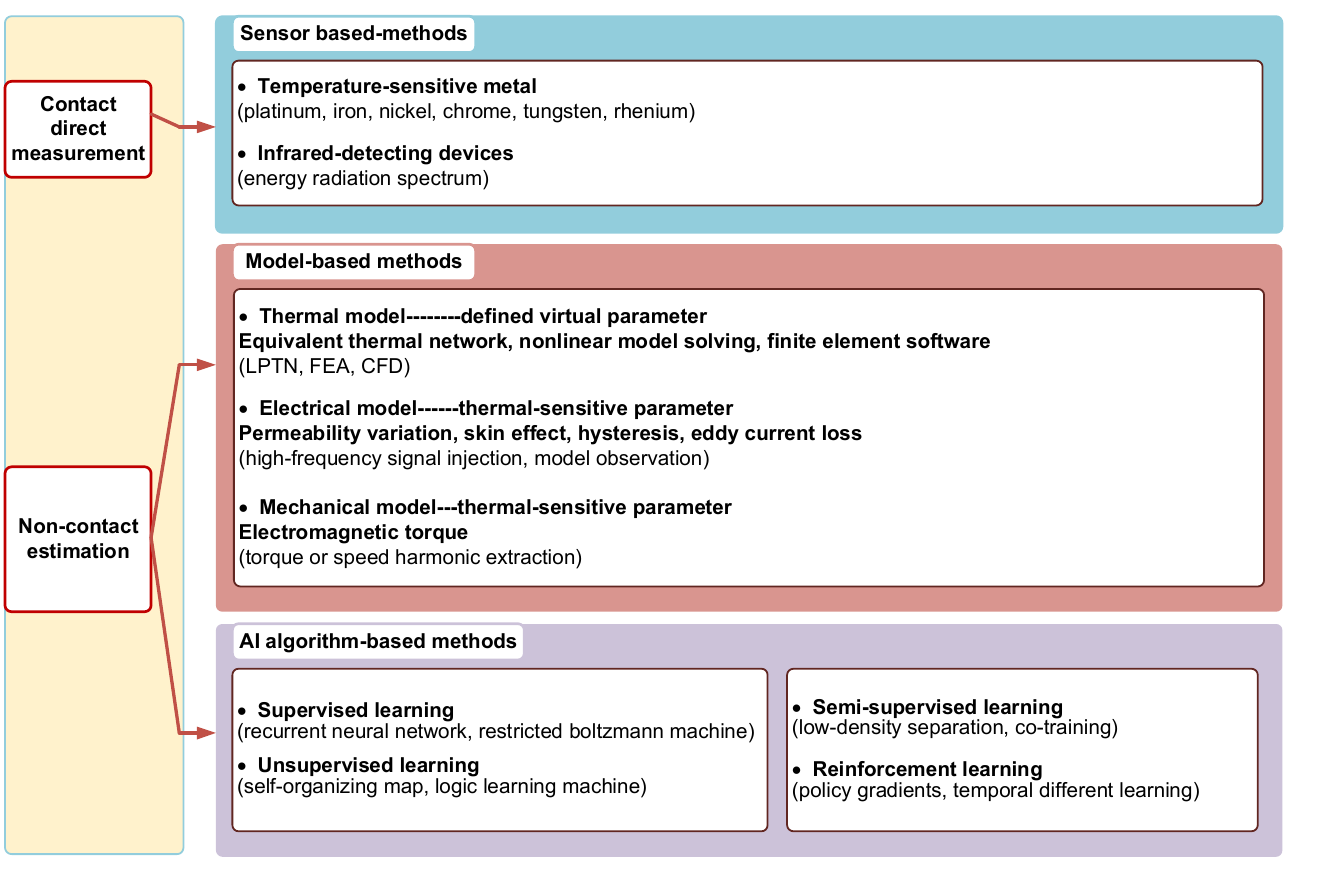
Figure 1. Categorization of temperature monitoring methods by techniques.